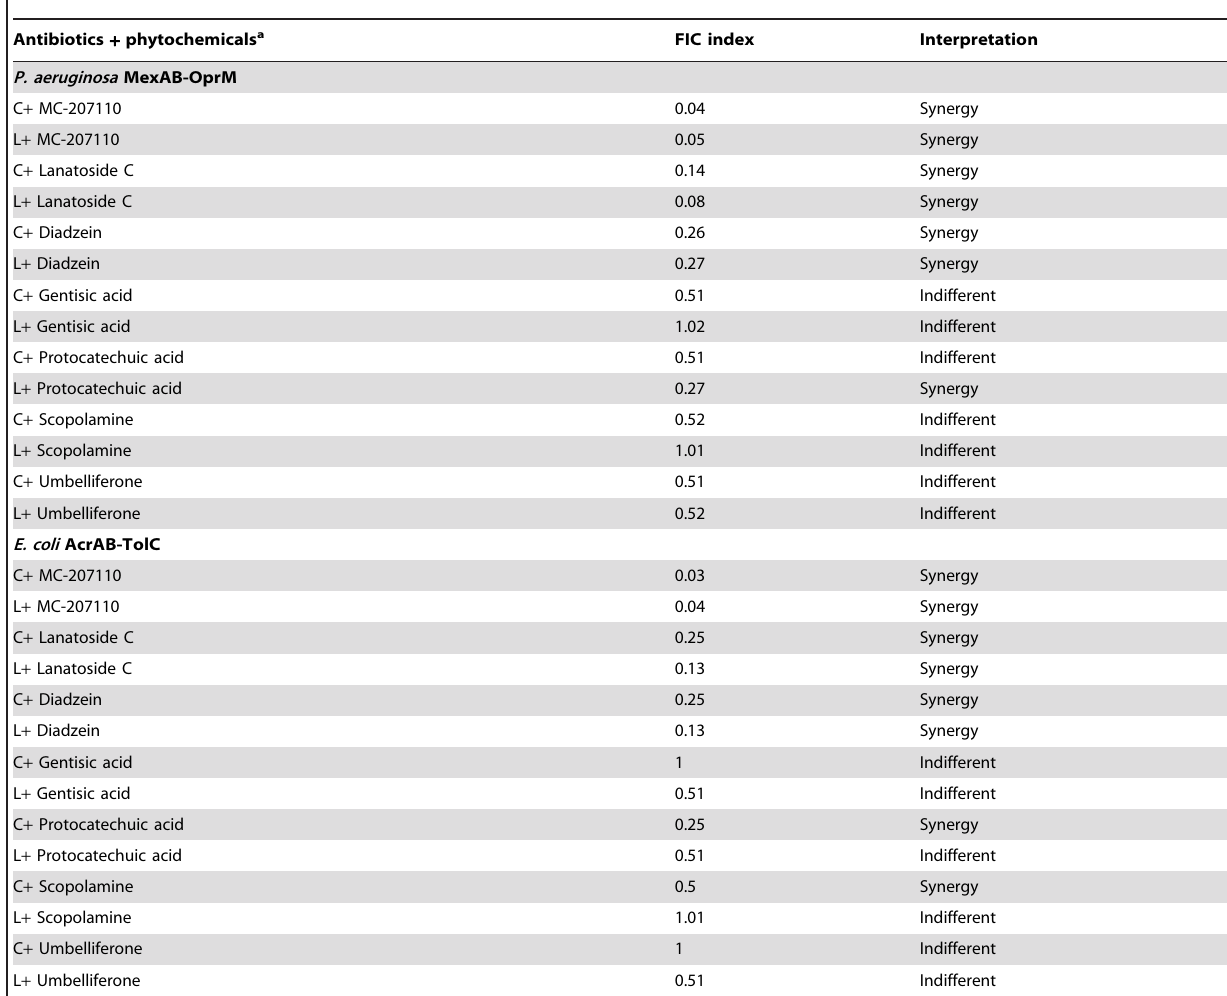
Table 3. Effect of phytochemicals and known EPI on the MIC of antibiotics using checkerboard synergy assay in P. aeruginosa and E. coli